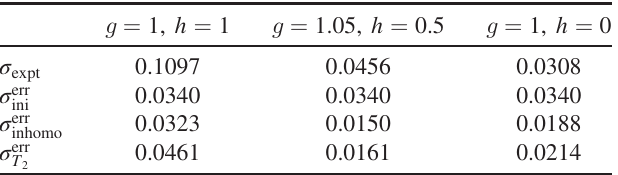
ˆ A i for the experiments ˆ A ¼ ˆ σ x 1 , ˆ B ¼ ˆ σ y 4 .